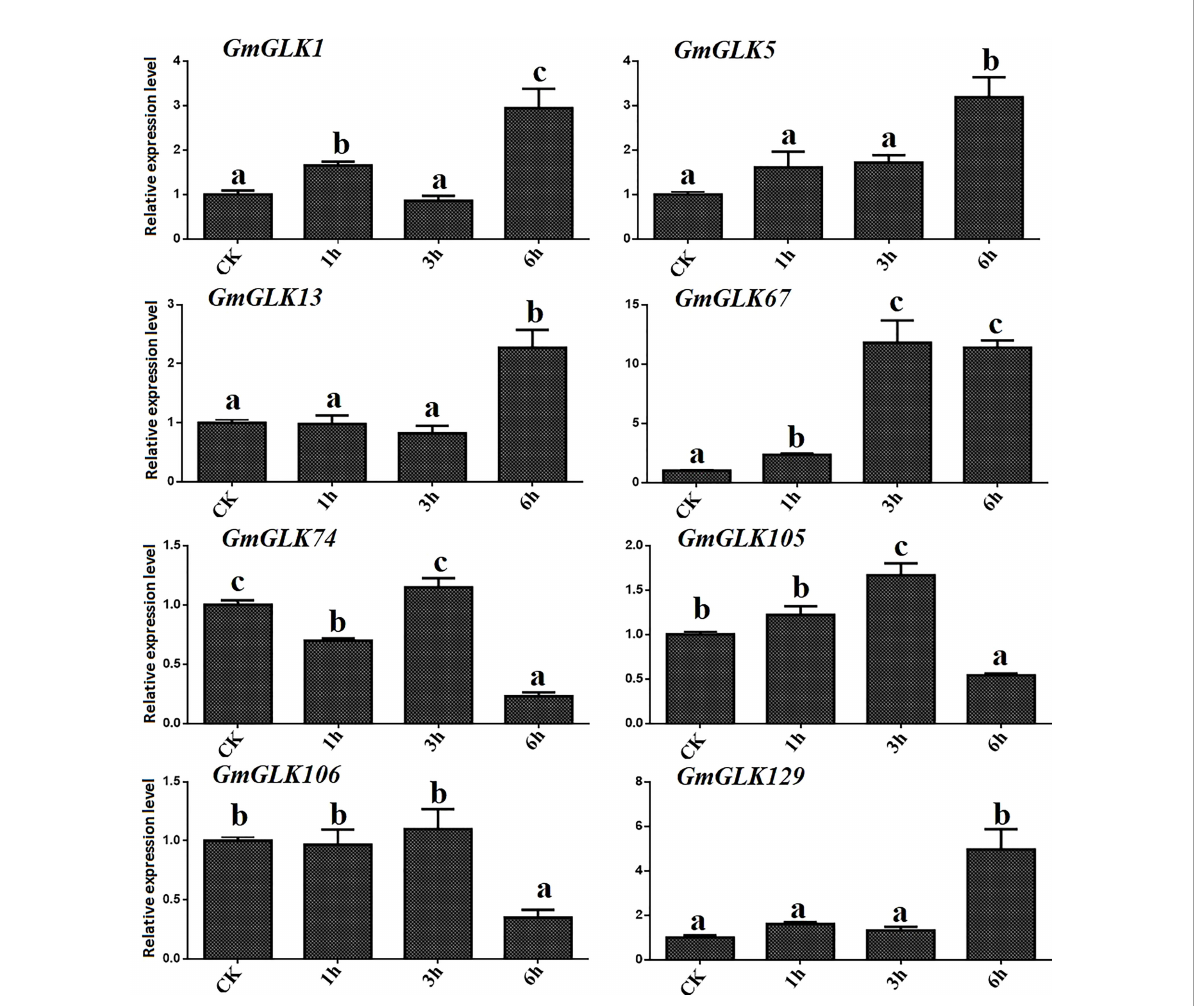
FIGURE 6 qRT-PCR analysis of the relative expression of GLK members in soybean under Cd stress. The time in hours is represented through the x-axis and relative expression level through y-axis. Tukey ’ s HSD tests were utilized to measure the differences among effects on various time frames for Cd exposure. The alphabetical letters indicate signi fi cant difference